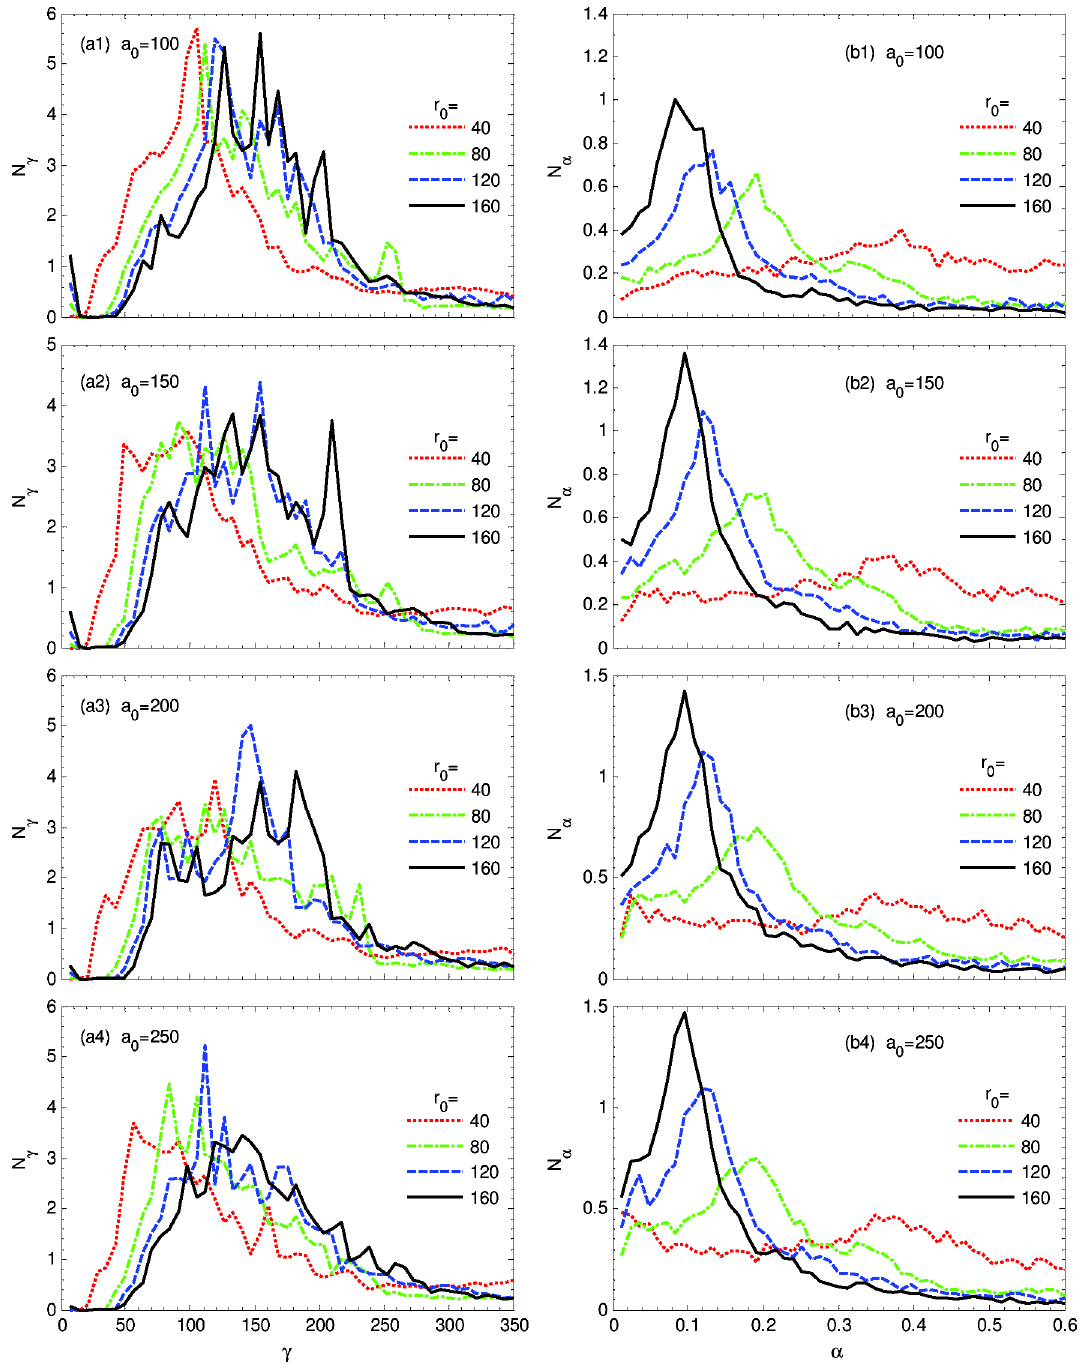
FIG. 9. Spectrum of (a1)–(a4) energy and (b1)–(b4) angle of emittance of the electrons generated during ionization of krypton by a laser pulse. The laser intensity parameters a 0 and laser spot size r 0 are specified in the figure itself. Here N (cid:5) and N (cid:8) are the number of electrons (relative scale) with energy lying within a range of relativistic factor and scattering lying within a range of angle of emittance,